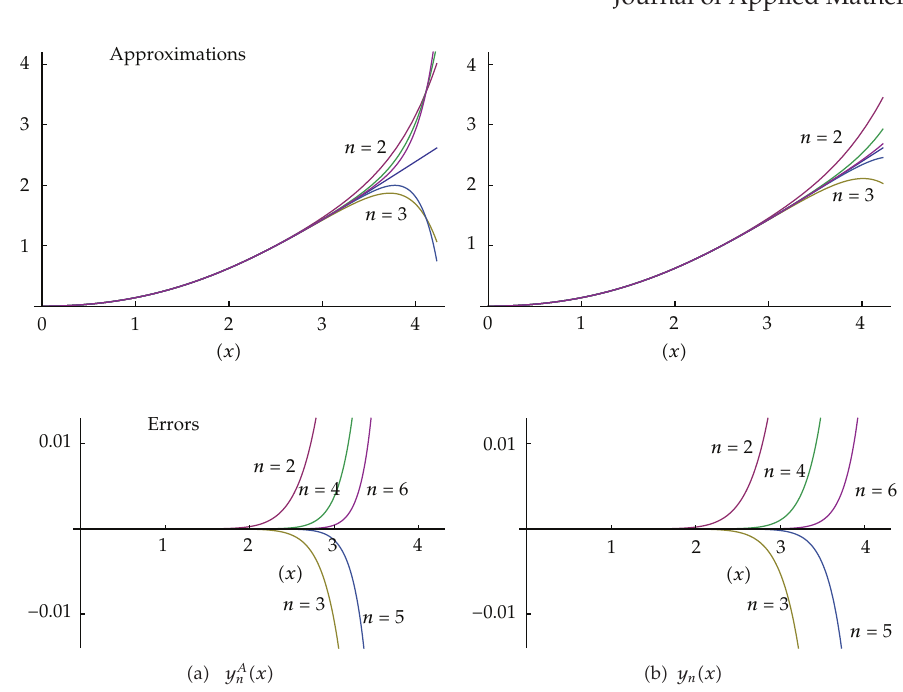
Figure 4: Adomian’s solutions y A n (cid:3) x (cid:4) and their errors in (cid:3) a (cid:4) and presented solutions y n (cid:3) x (cid:4) and their errors in (cid:3) b (cid:4) for the Falkner-Skan equation with β (cid:6) − 0 .